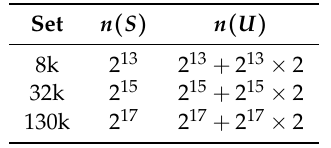
Table 2. Number of elements in experimental data